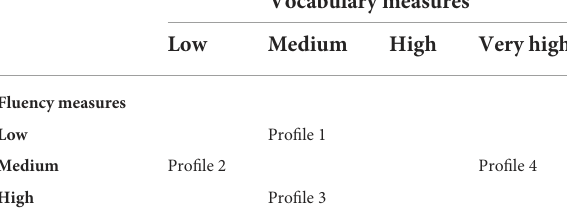
TABLE 10 Profile membership